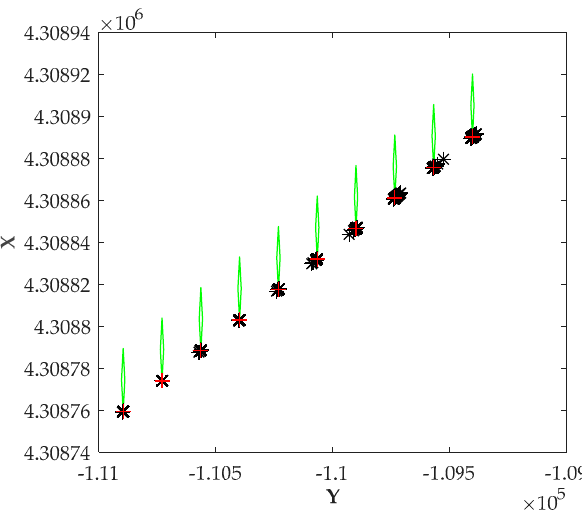
Figure 7. Positioning results with changing distance.